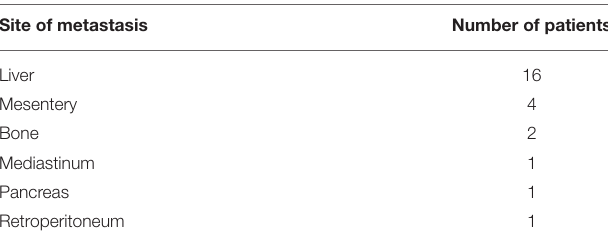
TABLE 1 | Sites of